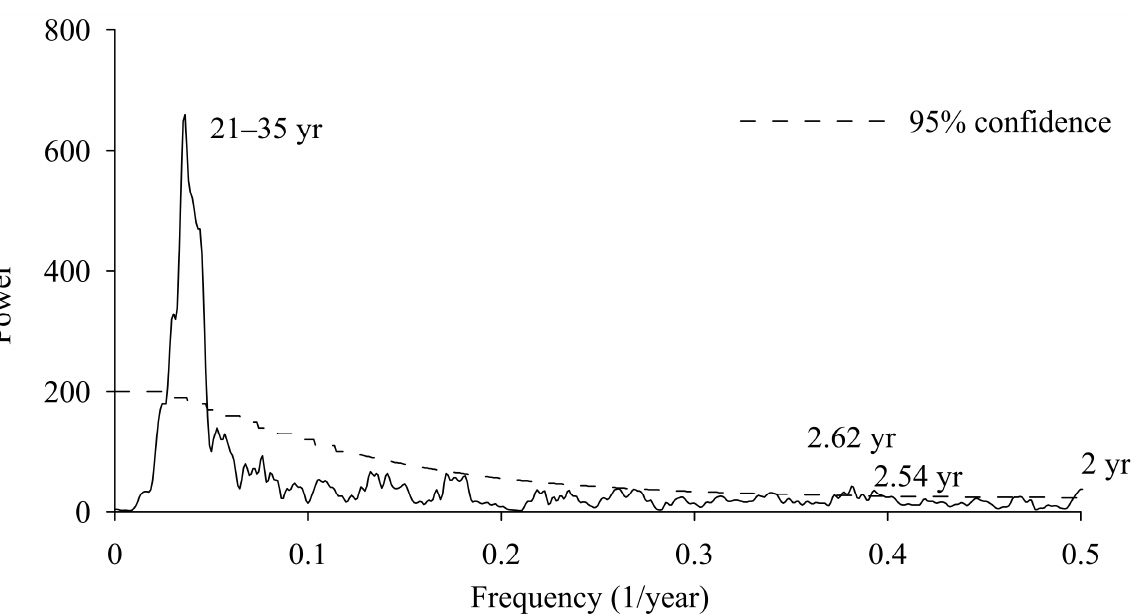
As shown in Figure 6, the results of MTM at a confidence level of 95% indicated that the reconstructed series mainly features an interannual variation period of 2 years and a decadal oscillation period of 21 to 35 years.